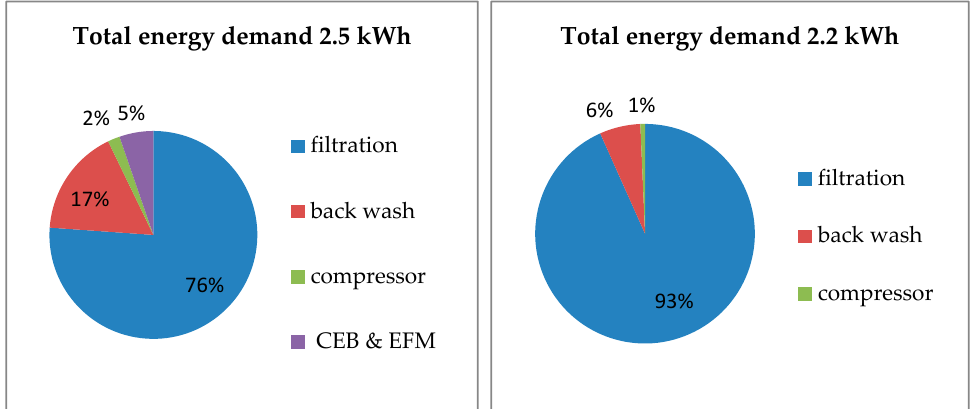
Figure 7. The percentage distribution of process-related energy demand for the filtration of Elbe River water with chemical cleaning ( left ) and for the filtration of bank filtrate without chemical cleaning ( right ). CEB, chemical enhanced backwash; EFM, enhanced flux maintenance. The filtrate production at a flux of 50 L/m² h was 12.9 m³/h for river water and 16.8 m³/h for bank filtrate. It varied depending on the flux. Energy consumption for chemical cleaning showed a significant difference between EFM and CEB. CEB had a total energy consumption of 1.63 kWh, EFM 17.1 kWh. Seventy-five percent (75%) of the energy was needed to heat up the cleaning solution to 32 °C.